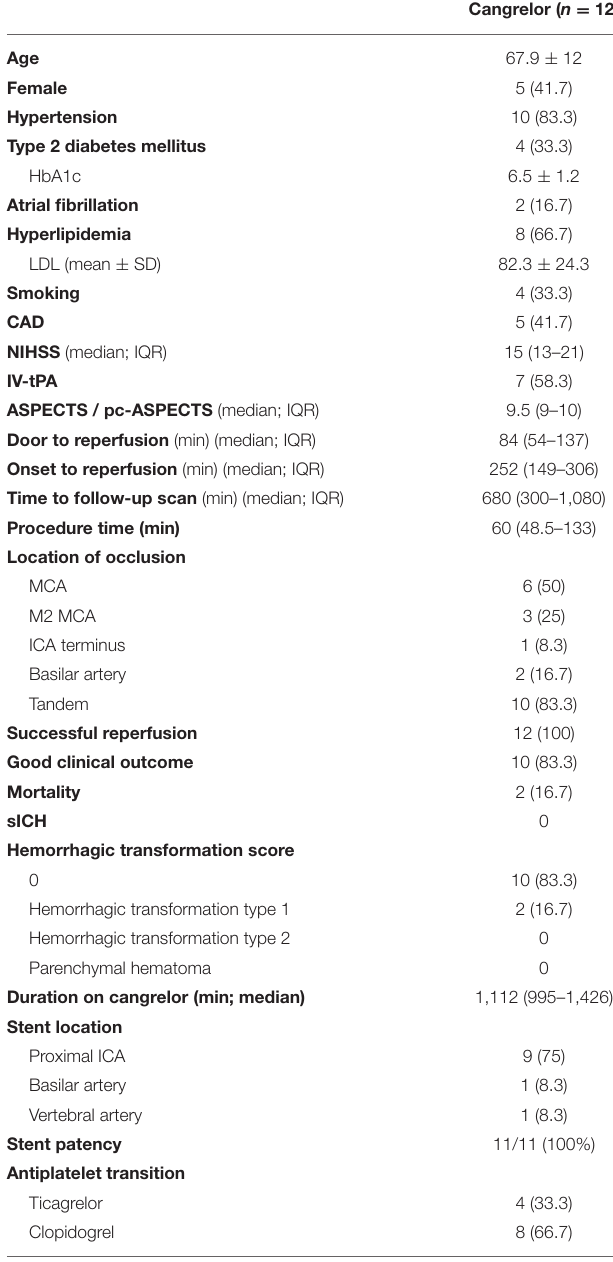
TABLE 1 | Baseline demographics and treatment variables for patients who received intravenous cangrelor for acute ischemic